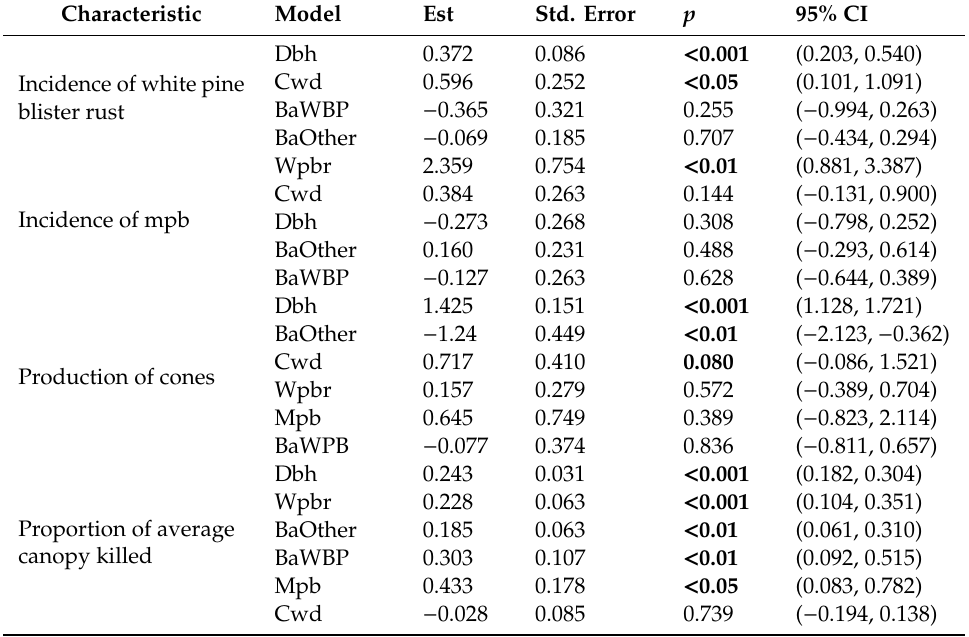
Table 4. Estimated e ff ects of site characteristics from the best supported Generalized Linear Mixed Model (GLMM) of the probability of producing cones (no = 0, yes = 1), probability of white pine blister rust infection (uninfected = 0, infected = 1), the probability of mountain pine beetle infestation (uninfested = 0, infested = 1), and the proportion of average canopy kill in Crater Lake National Park. p -values indicate the significance of the Wald Z-test